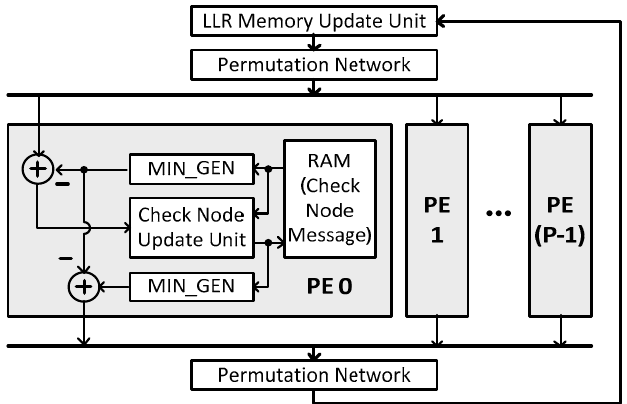
Figure 7. Block diagram of Low Density Parity Check (LDPC) decoder.